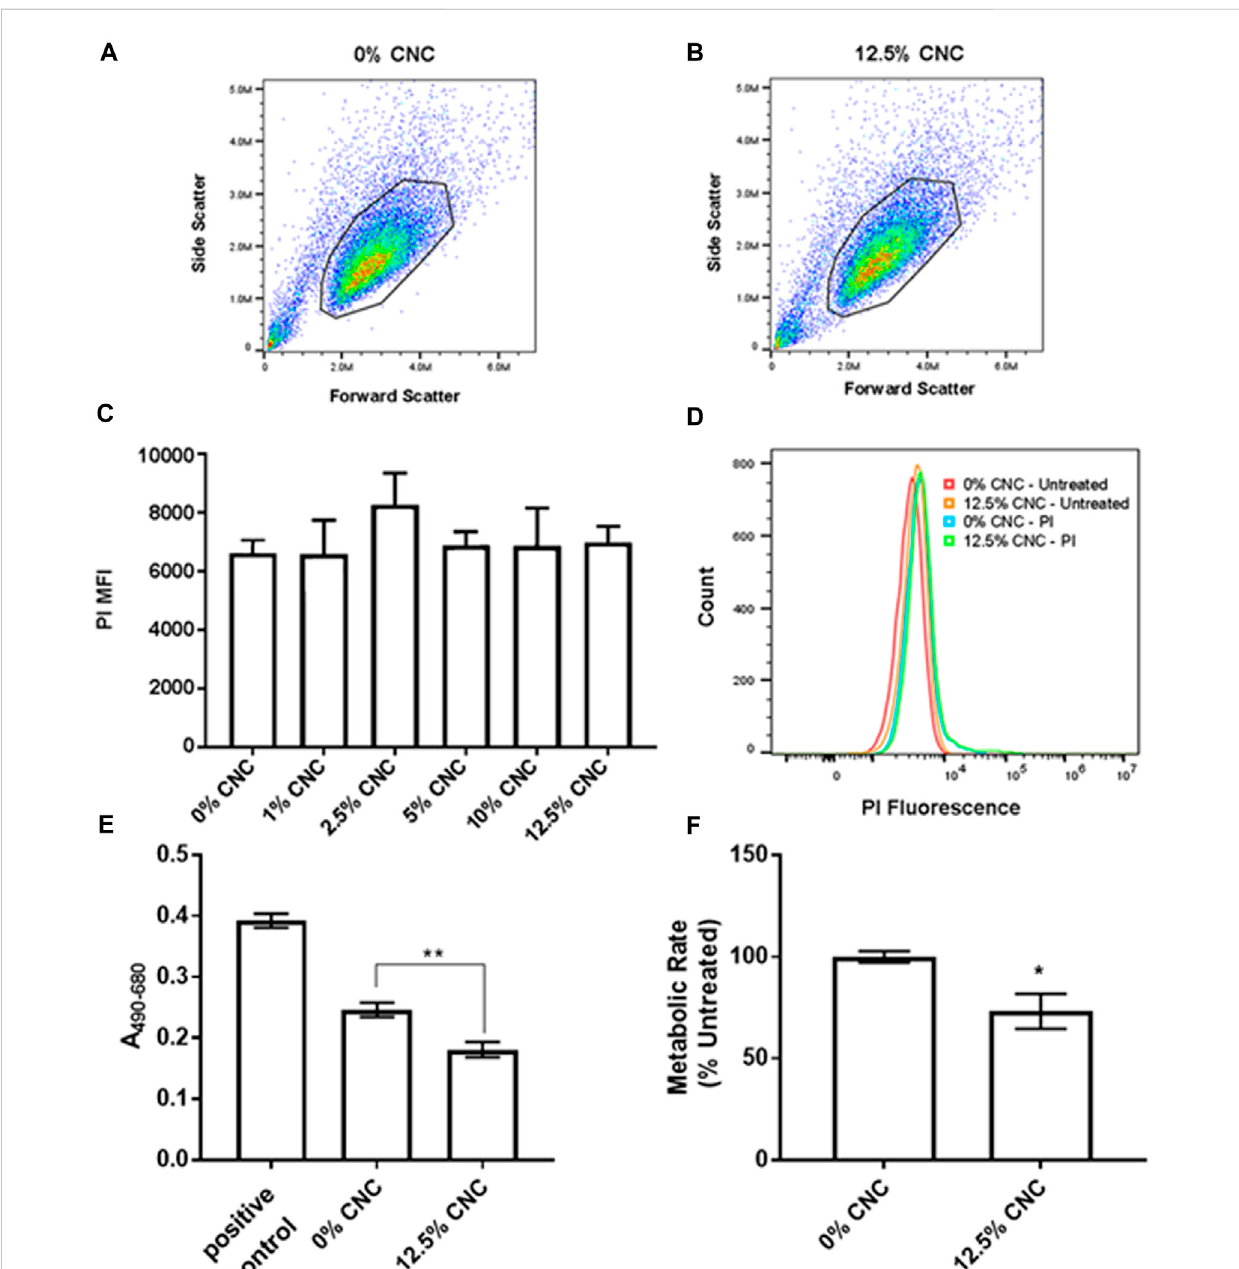
FIGURE 3 Viability and metabolic activity of cells cultured on CNC/agarose substrates. (A, B) Forward scatter ( X -axis) versus side scatter ( Y -axis) dot plot analysis of total cell population from (A) untreated control BMMC (0% CNC) and (B) BMMC cultured on 12.5% CNC/agarose substrate for 18 h depicting the gated cell population used for data analysis. (C) BMMCs were cultured on different CNC/agarose substrate concentrations (1% – 12.5% (w/v) CNC) for 18 h, and cell membrane integrity was determined by fl ow cytometric analysis of propidium iodide (P1) stained cells. Graphical representation of PI mean fl uorescence intensity (MFI) for BMMCs incubated on different CNC/agarose substrates relative to BMMCs that were untreated (0% CNC/agarose) and stained with PI ( n = 4). (D) Histogram overlay pro fi le of gated cells (unstained or stained with PI), from untreated control BMMCs (0% CNC/agarose) and BMMCs cultured on 12.5% CNC/agarose. (E) LDH release from BMMC incubated on CNC/agarose matrix for 24 h with a 0.1% triton X-100 positive control for LDH release. (F) BMMC were incubated on CNC/agarose matrix for 24 h and metabolic activity was determined by measuring reduction